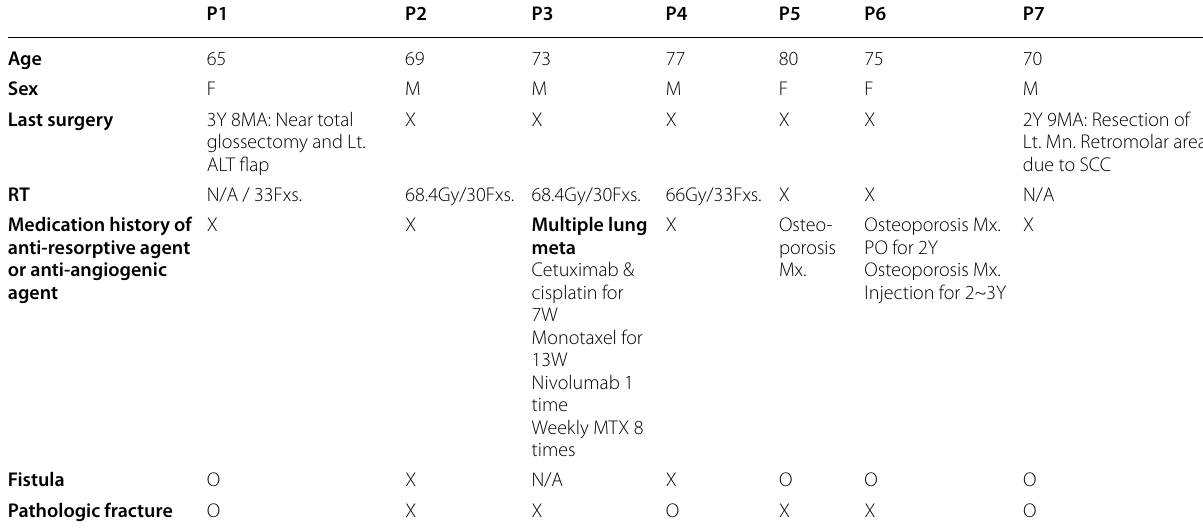
Table 1 Summary of preoperative patient